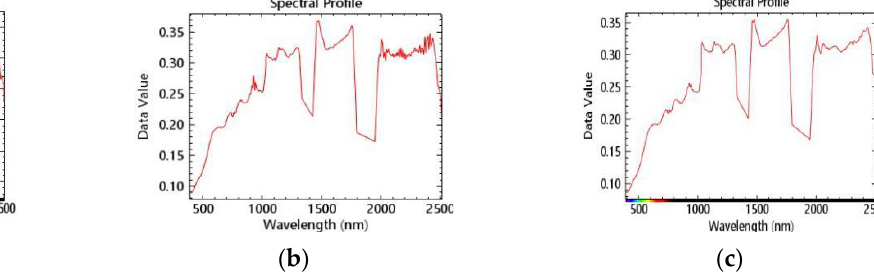
Figure 6. The spectral curve of a point (lat: 32.8°, lon: 37.6°): ( a ) Original; ( b ) MNF; and ( c ) SNLRSF.